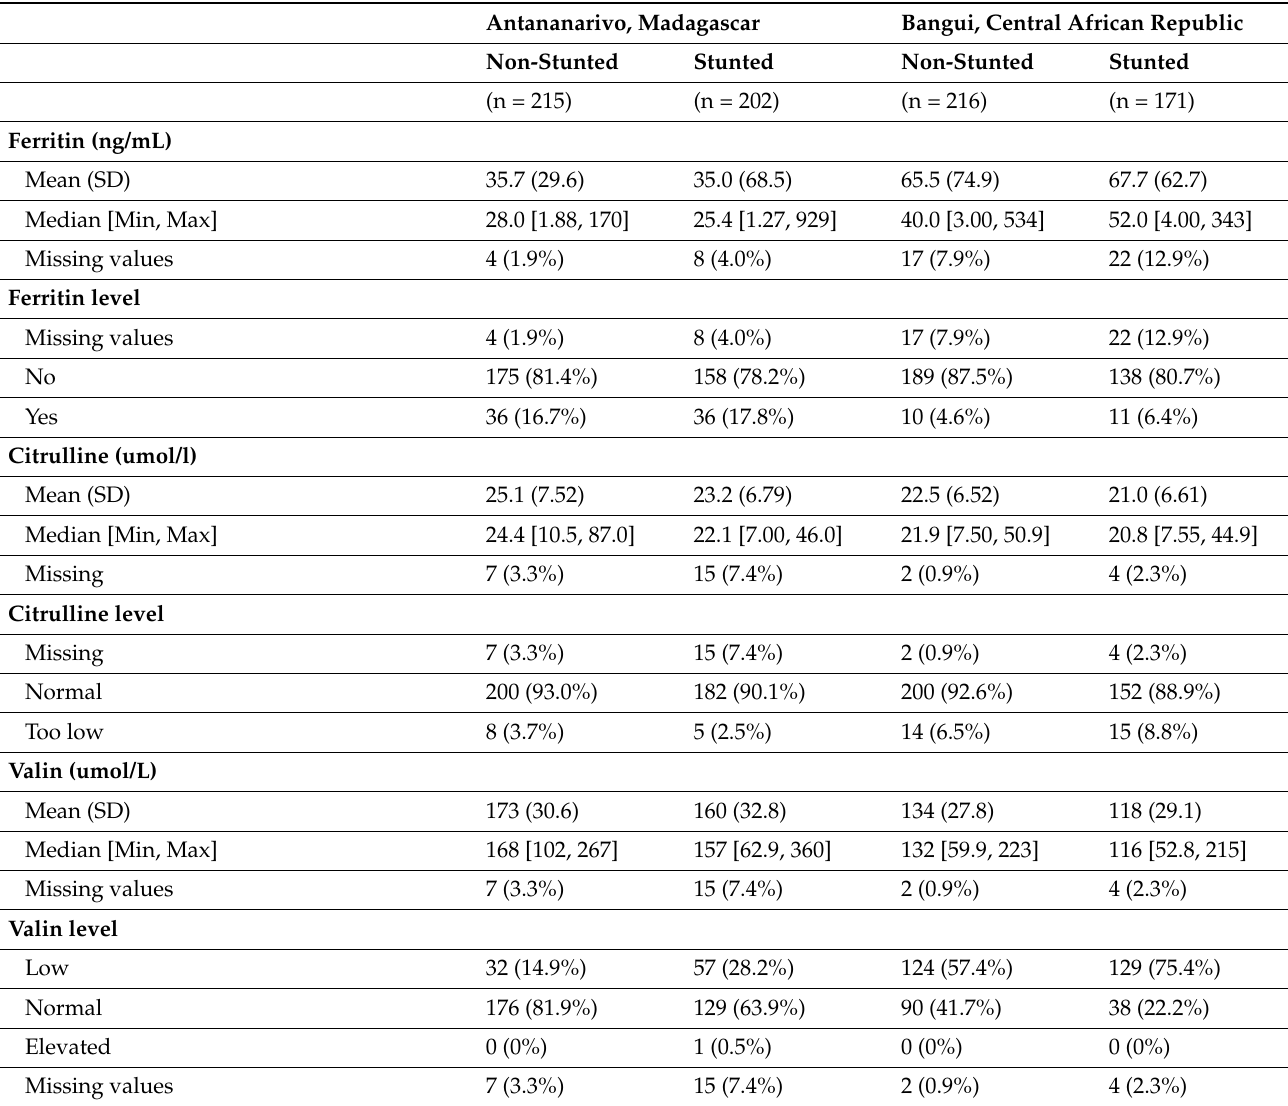
Table 2. Description of the main putative biomarkers. Antananarivo,